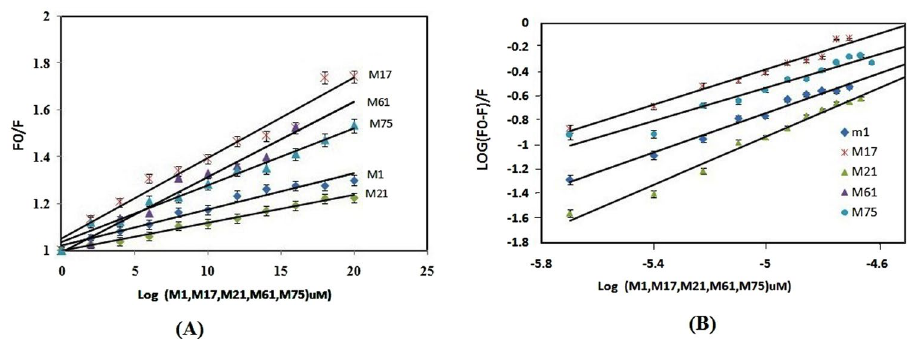
Figure 5. ( A ). M1, M17, M21, M61, M75 -induced fluorescence quenching of NDM-1 at 298 K. ( A ) Stern − Volmer plot and ( B ) modified stern Volmer for NDM-1 − M1, M17, M21, M61,M75 interactions.